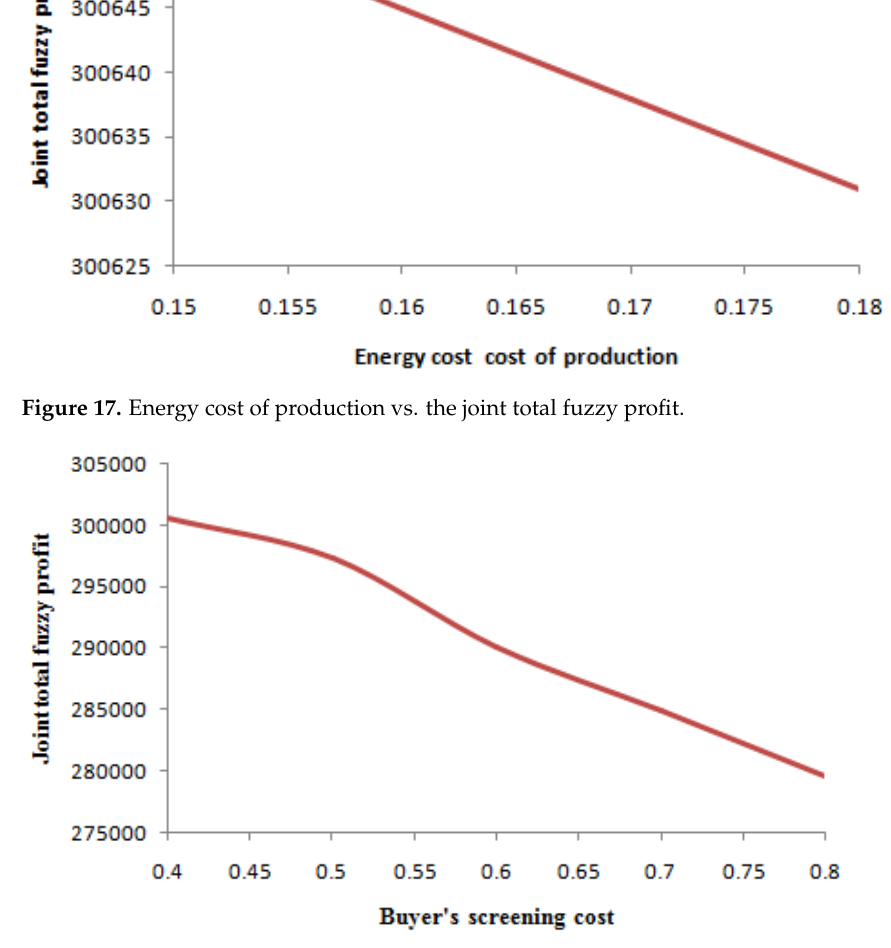
Figure 18. Buyer’s screening cost vs. the joint total fuzzy profit.